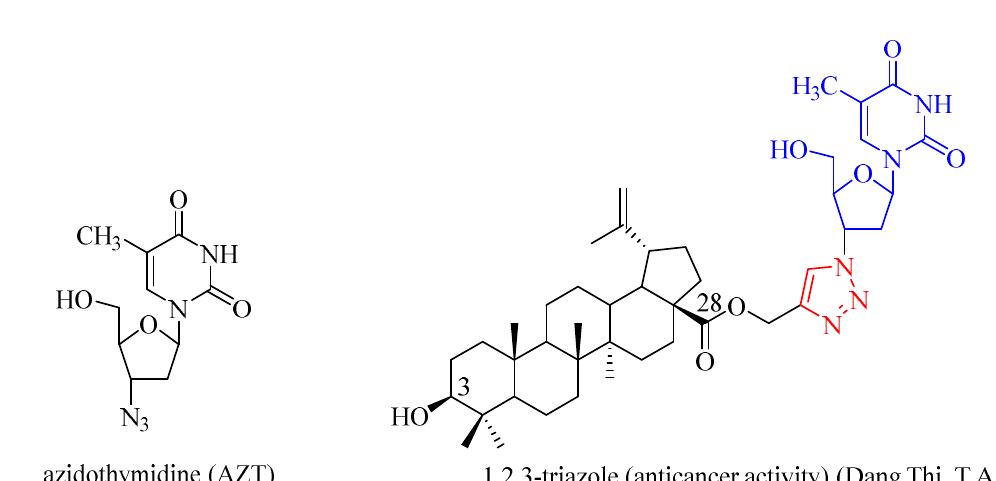
Figure 1. Chemical structure of azidothymidine (AZT) and 1,2,3-triazole derivative [13].